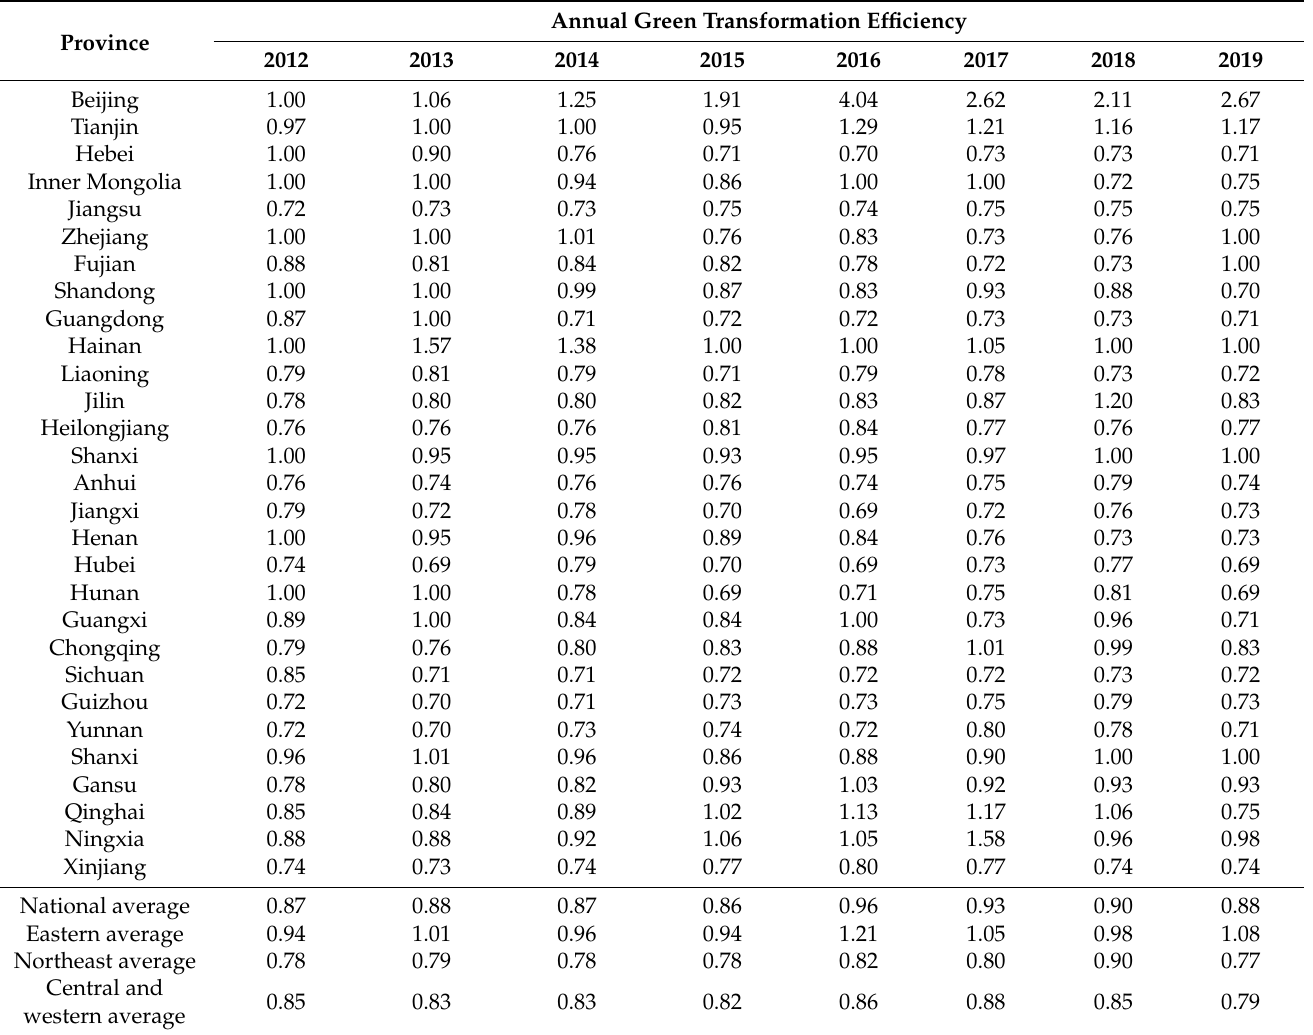
Table 1. Efficiency of the green transformation of resource industries in China,